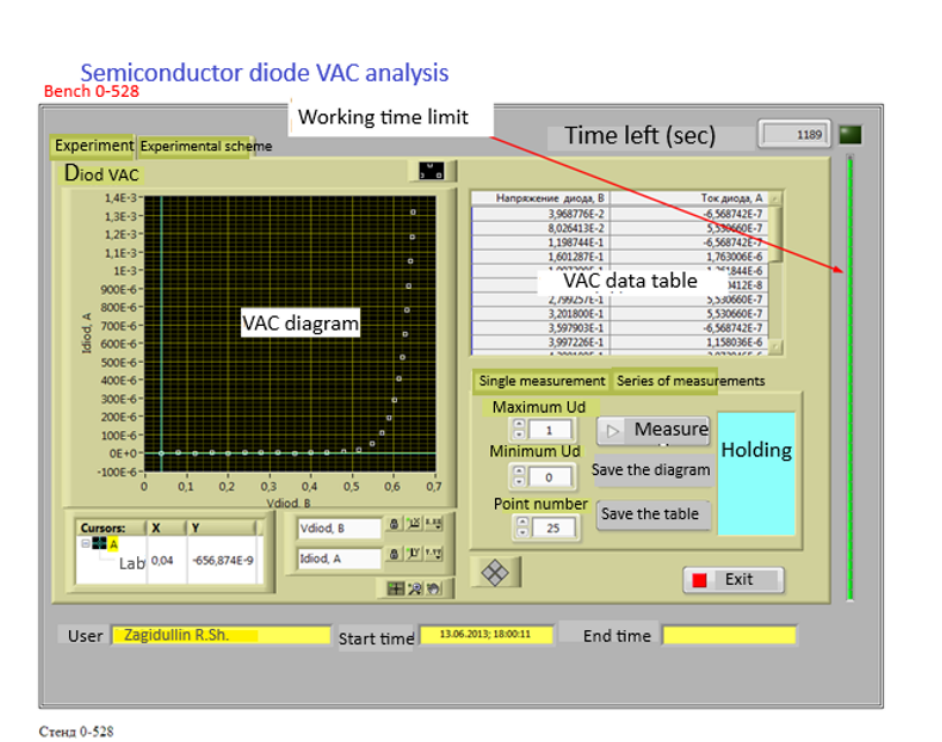
Fig. 6. Front control panel of the laboratory